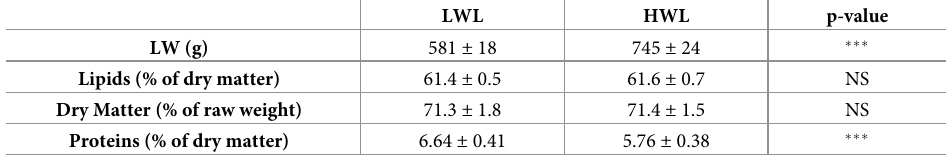
Table 1. Liver weights (LW), gross chemical composition and color parameters of livers from the two studied groups (n = 8 samples / group). LWL HWL p-value LW (g) 581 ± 18 745 ± 24 ��� Lipids (% of dry matter) 61.4 ± 0.5 61.6 ± 0.7 NS Dry Matter (% of raw weight) 71.3 ± 1.8 71.4 ± 1.5 NS Proteins (% of dry matter) 6.64 ± 0.41 5.76 ± 0.38 ��� Values are means ± SD. Within a line, p-values indicate the level of significance ( � P � 0.05, �� P � 0.01, ��� P � 0.001, and NS: not